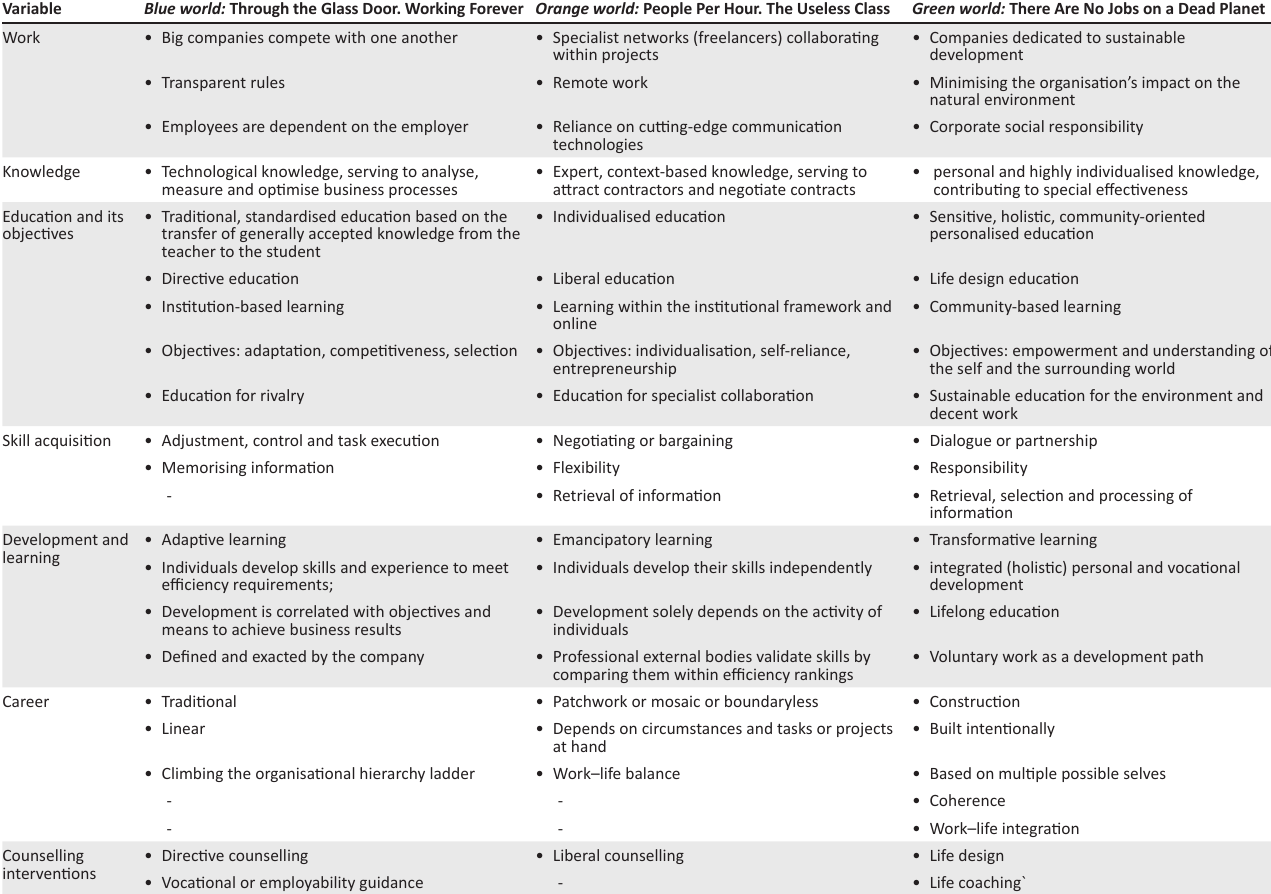
TABLE 1: Future scenarios and education.